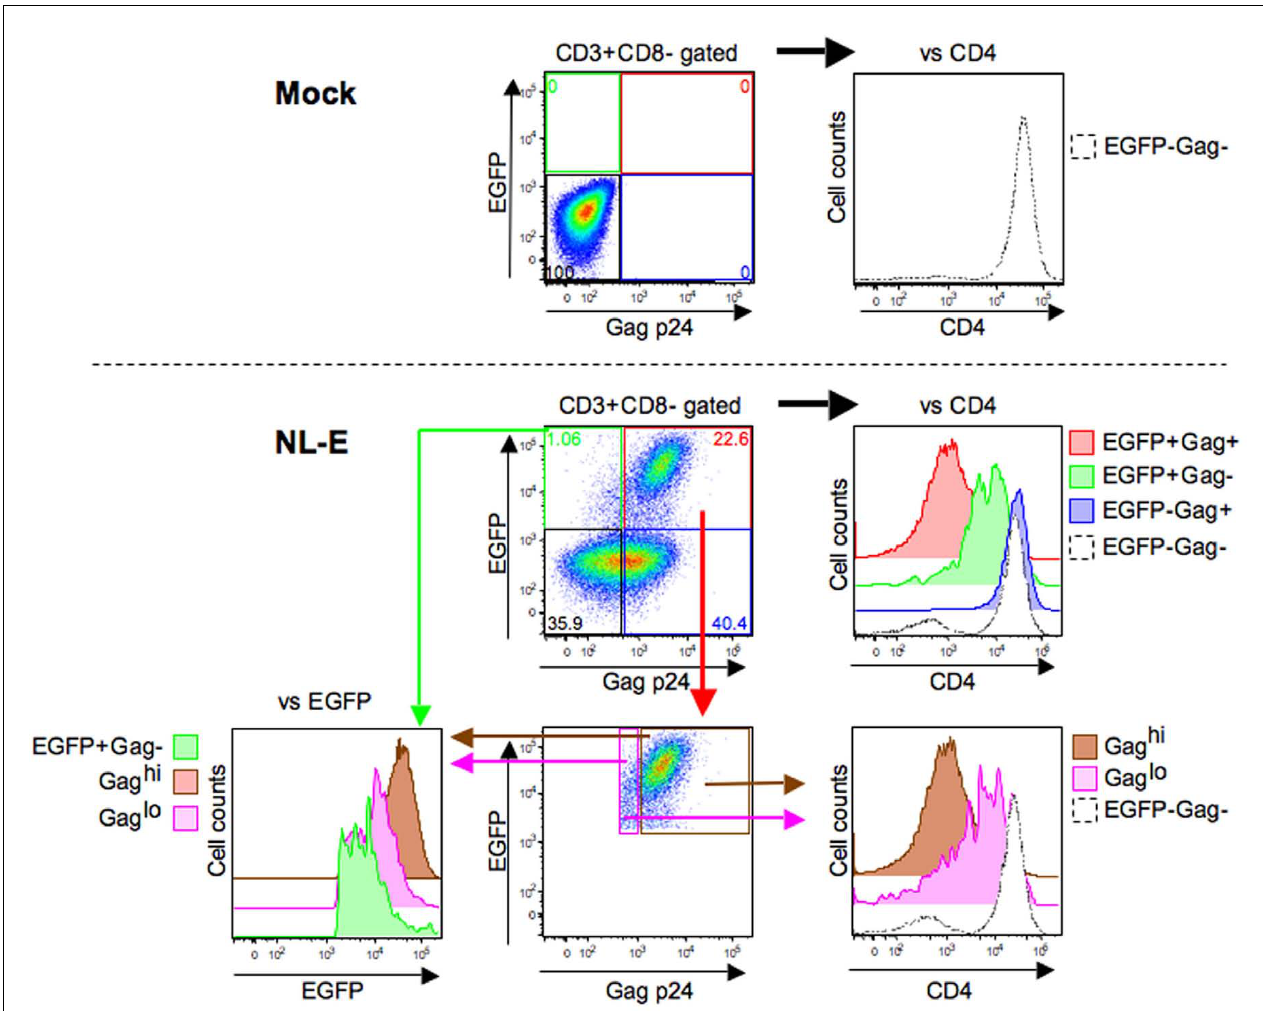
FIGURE 4 | Correlation between HIV-1 fluorescent reporter signal and Gag p24 expression. Representative flow cytometric analyses of the mock and HIV-1 NL-E infection groups from six donors.These infection groups were prepared as outlined in the legend to Figure 2 .The EGFP + Gag + (red),